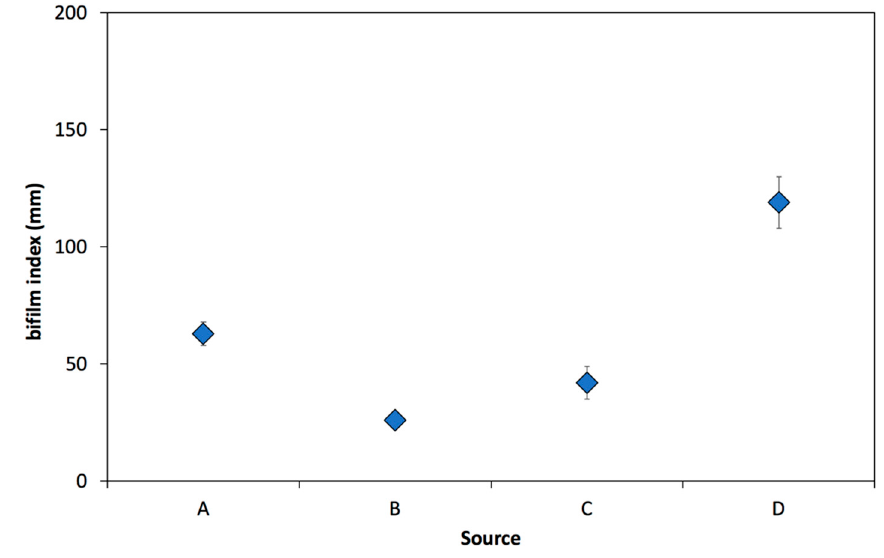
Figure 10. Change in bifilm index of different sources.